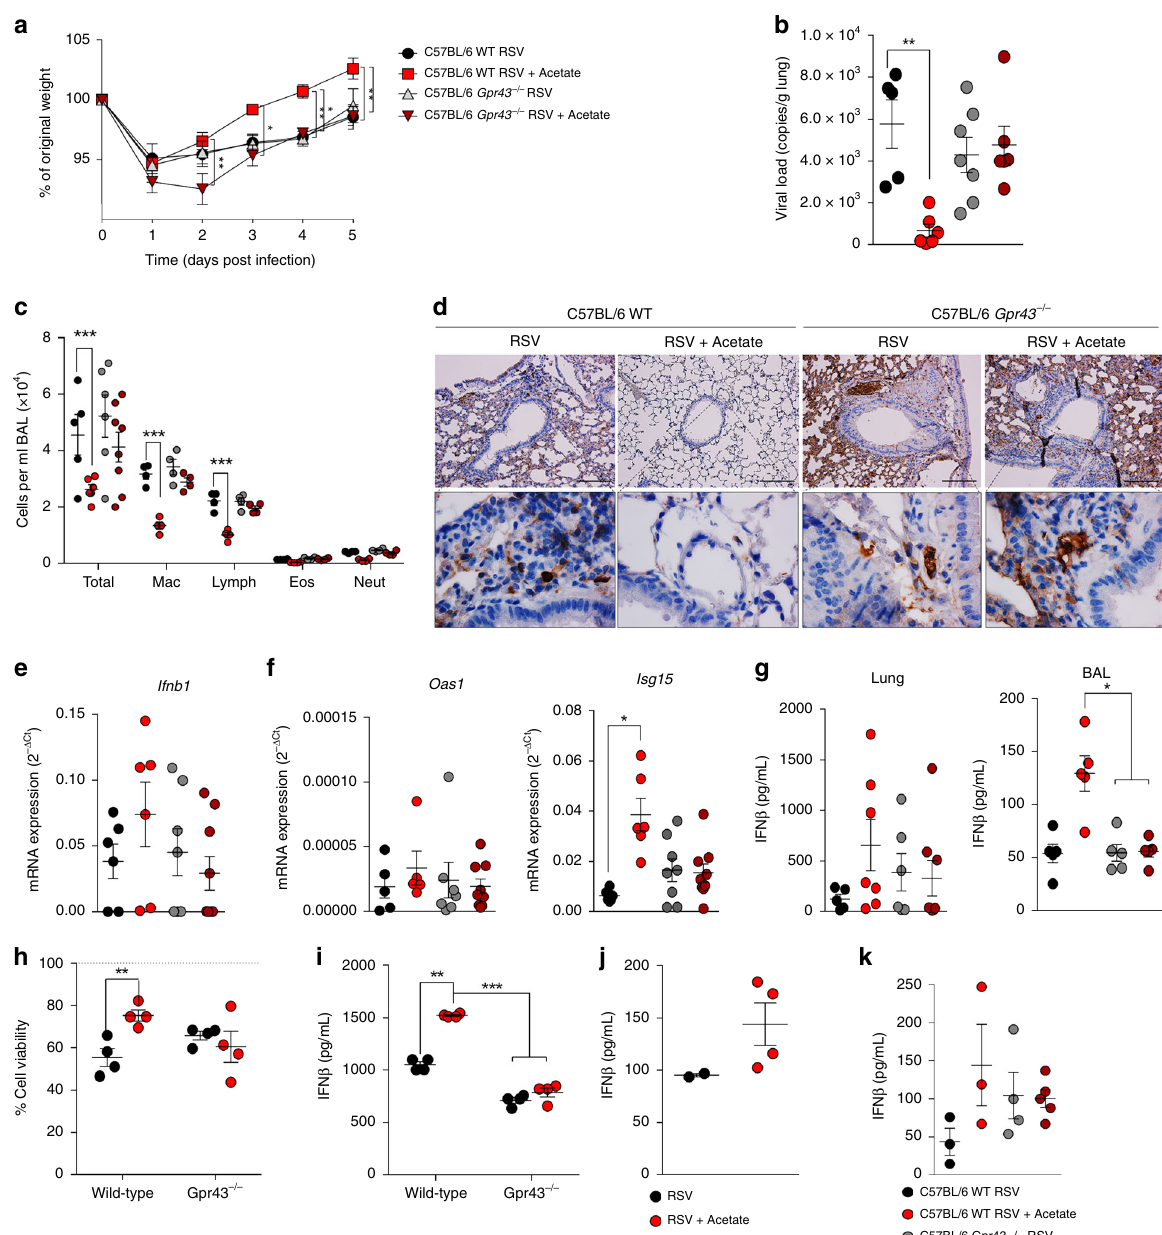
Fig. 9 GPR43 is necessary for acetate protection of RSV-induced disease. a – g Gpr43 (G-protein coupled receptor 43) knockout mice (background in C57BL/6) and their controls (WT) were infected with RSV and treated with 200 mM acetate in drinking water. Analyses were performed on day fi ve post infection. a Percentage weight loss post infection relative to original weight (day 0) (WT, n = 6; Gpr43 − / − , n = 9). b RSV viral load detected in